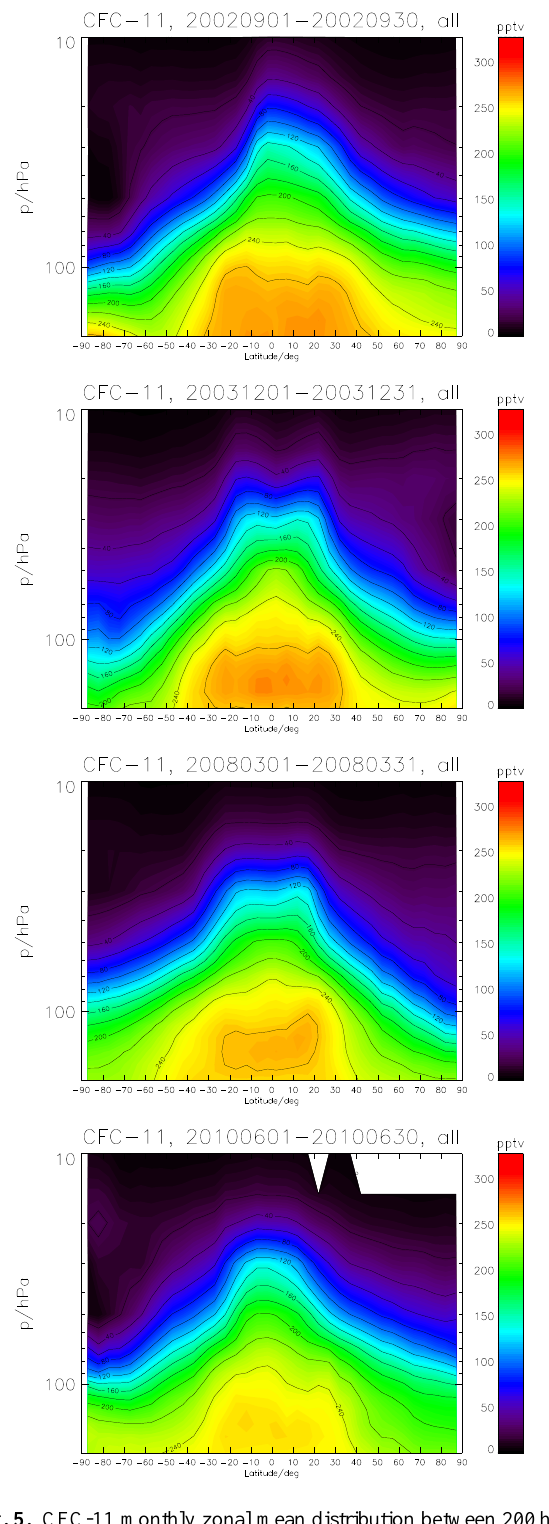
Fig. 5. CFC-11 monthly zonal mean distribution between 200hPa and 10hPa in September 2002, December 2003, March 2008, and June 2010.